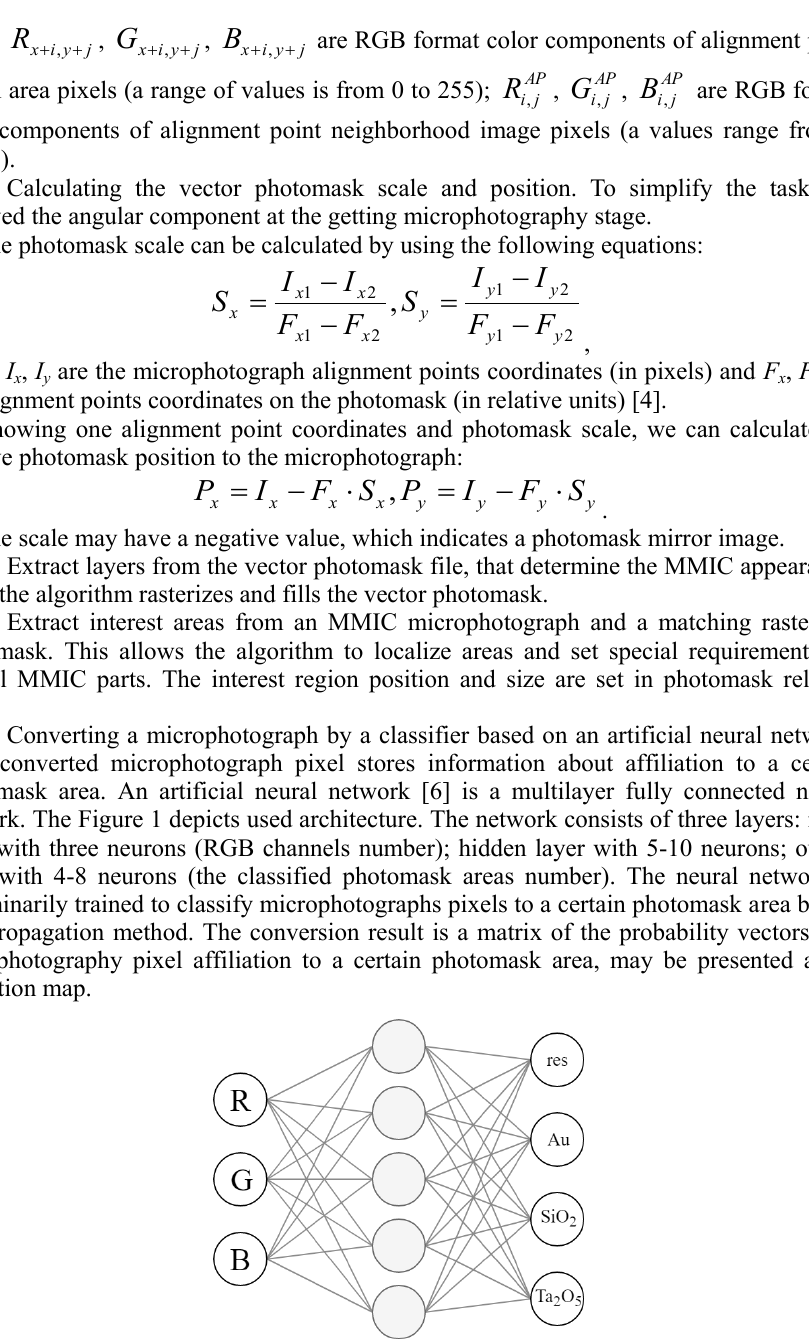
Fig. 1. The architecture of an artificial neural network for classifying microphotograph area pixels of an MMIC containing SiO 2 surfaces, metallization elements, resistors, capacitors based on Ta 2 O